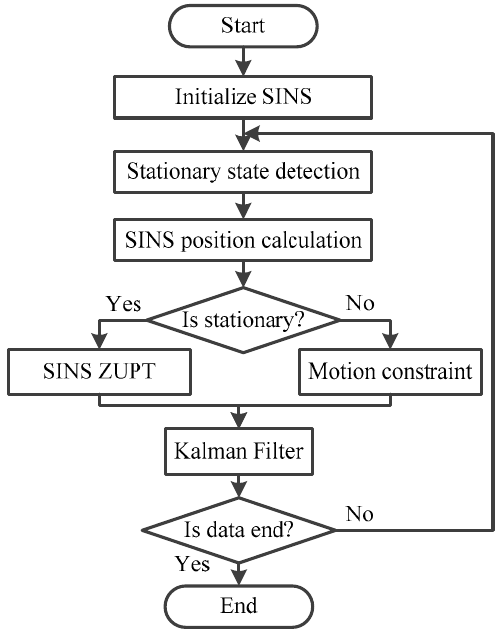
Figure 5. Flowchart of the shearer positioning model with the motion constraint-aided sins zero velocity updated (ZUPT) method.